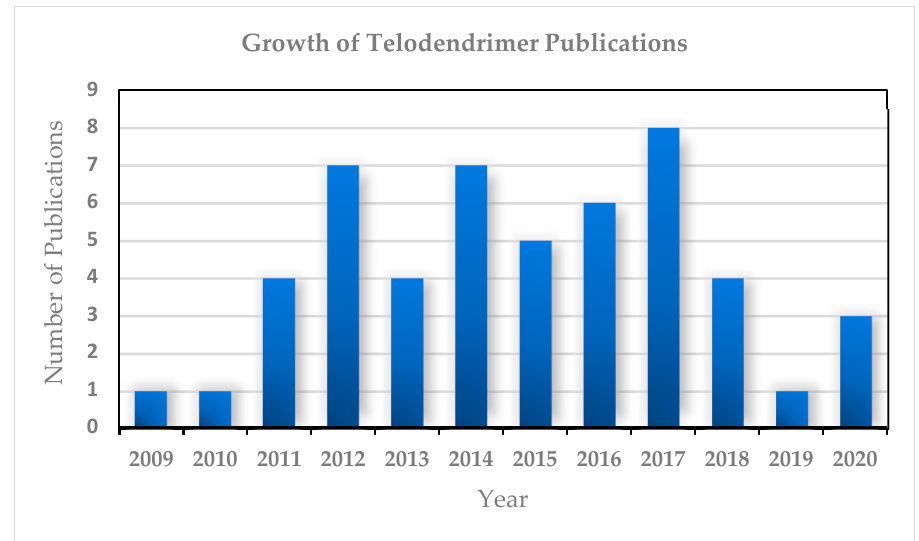
Figure 11. Brief analysis of publications on telodendrimers from 2009–2020 [211]. Note: Publications in 2020 are not complete at this stage.